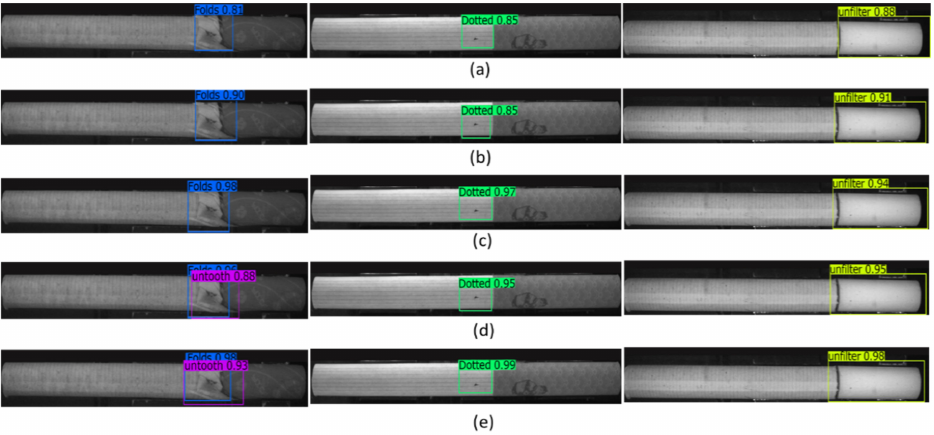
Figure 13. Comparison of the different network detection results: ( a ) Faster R-CNN; ( b ) SSD; ( c ) YOLOv5; ( d ) CenterNet; ( e ) C-CenterNet.